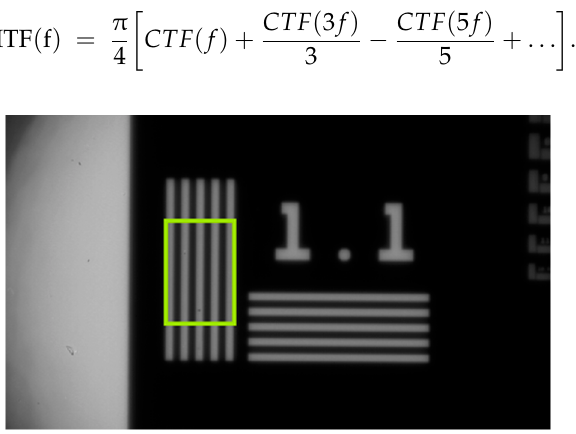
Figure 4. A representative image of the commercial NBS1963A CTF plate showing the ROI used to extract the CTF values, which were then converted to an MTF.